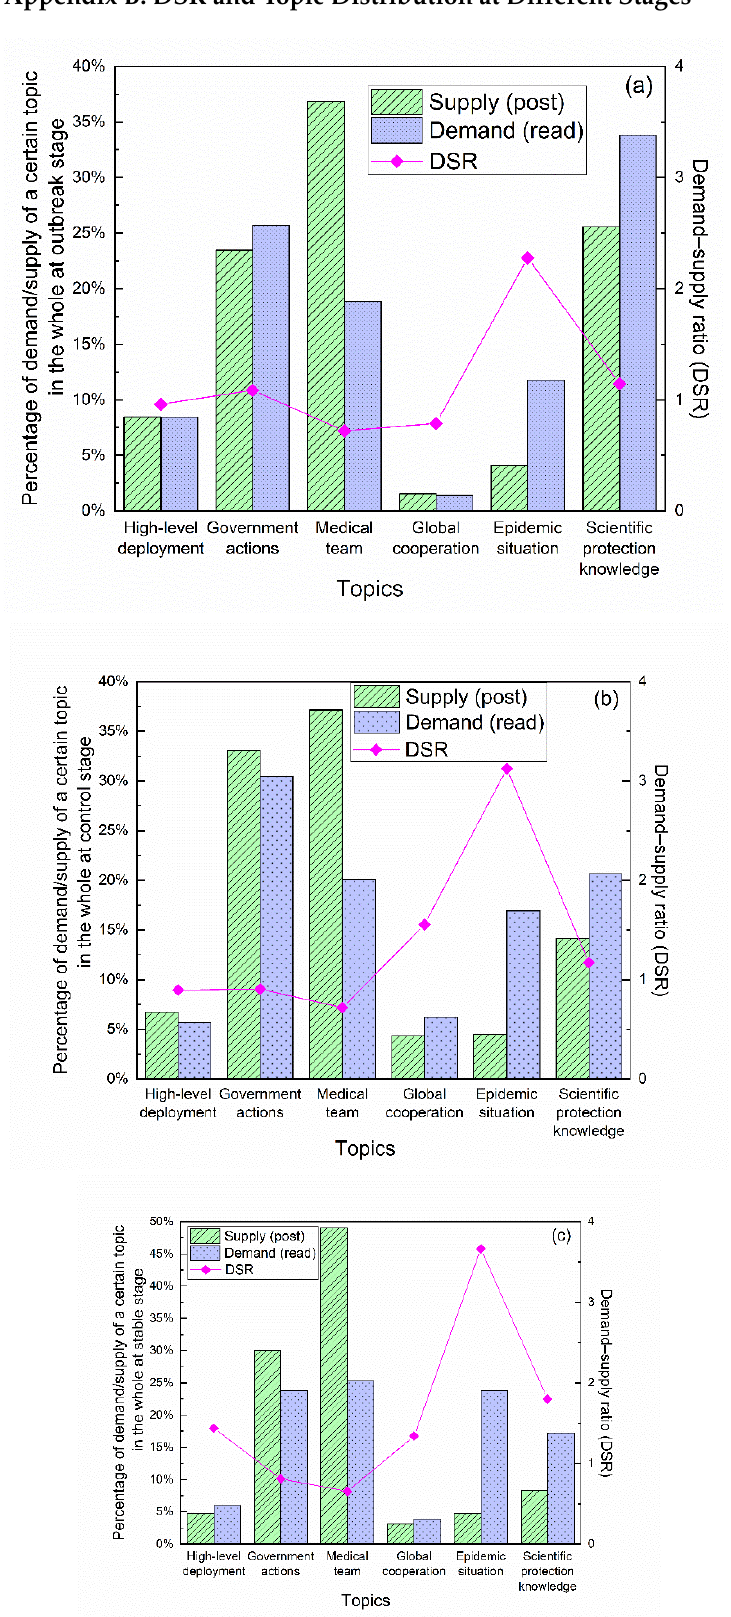
Figure A1. DSR and topic distribution at ( a ) outbreak stage, ( b ) control stage and ( c ) stable stage.